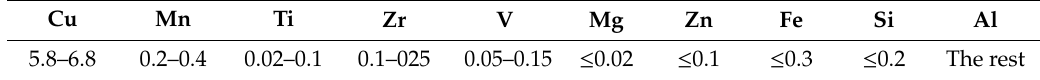
Table 2. Chemical composition of 2219 aluminum alloy (wt%).